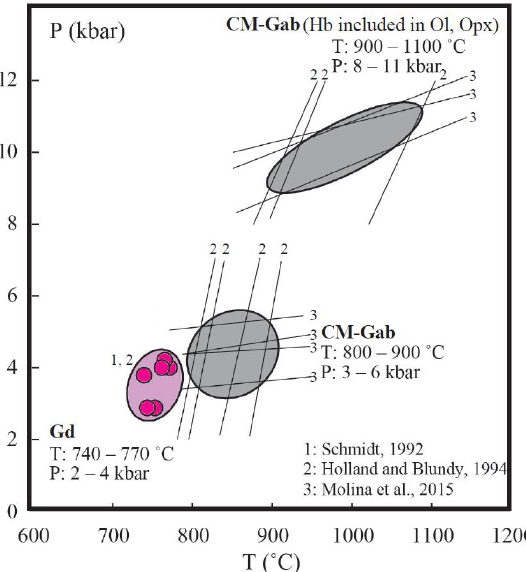
Figure 9. P – T diagram showing crystallization conditions for CM-Gab and the granodiorite. Pres- sure and temperature conditions of CM-Gab and the granodiorite adopted methods of